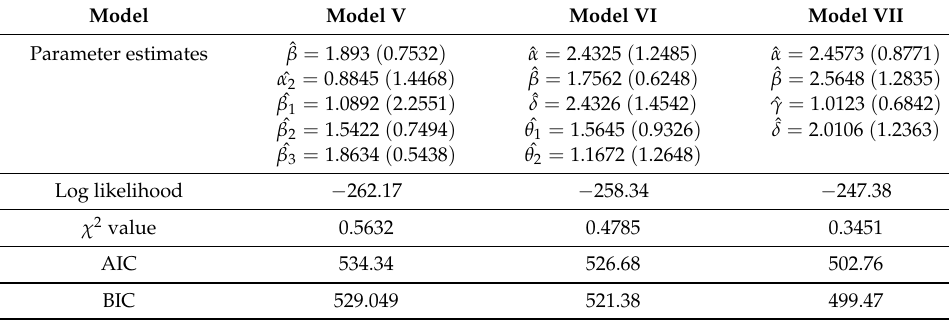
Table 5. Parameter estimates for Data Set